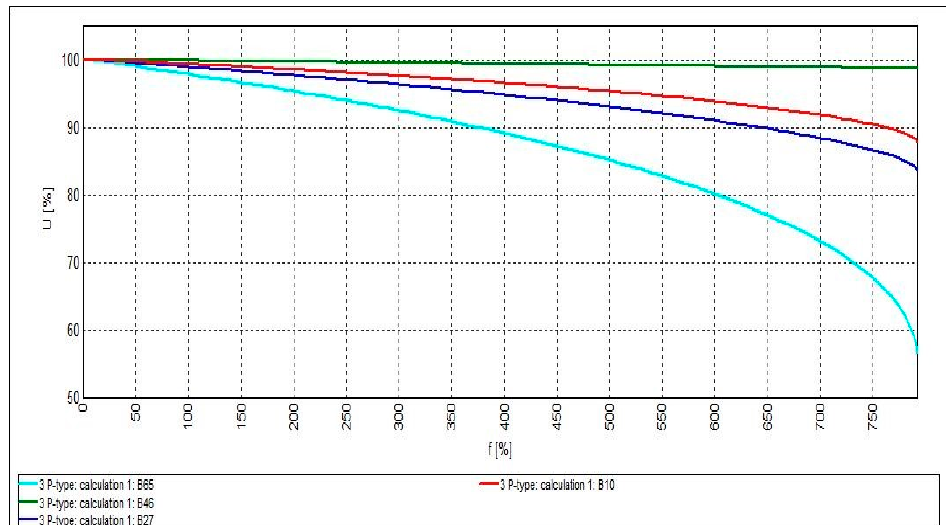
Figure 6. PV curves of the IEEE 69 ‐ node RDS system with 3 P ‐ type DG installations.